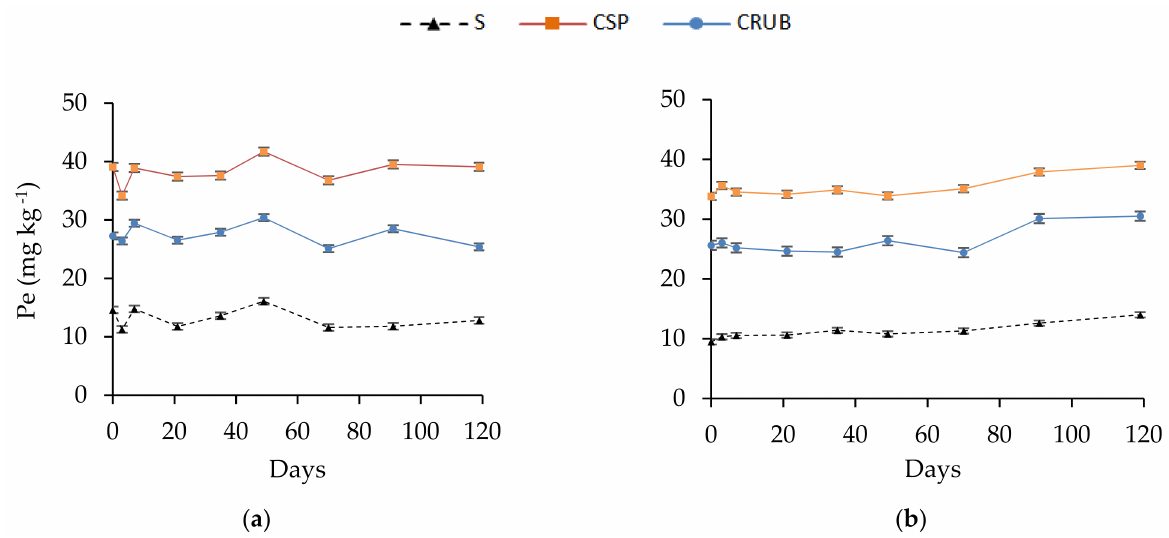
Figure 4. Dynamics of Pe for each treatment and date. ( a ): S1; ( b ): S2. S: control; CSP: poultry manure and wheat straw; CRUB: biosolids and wood shavings. Bars represent standard